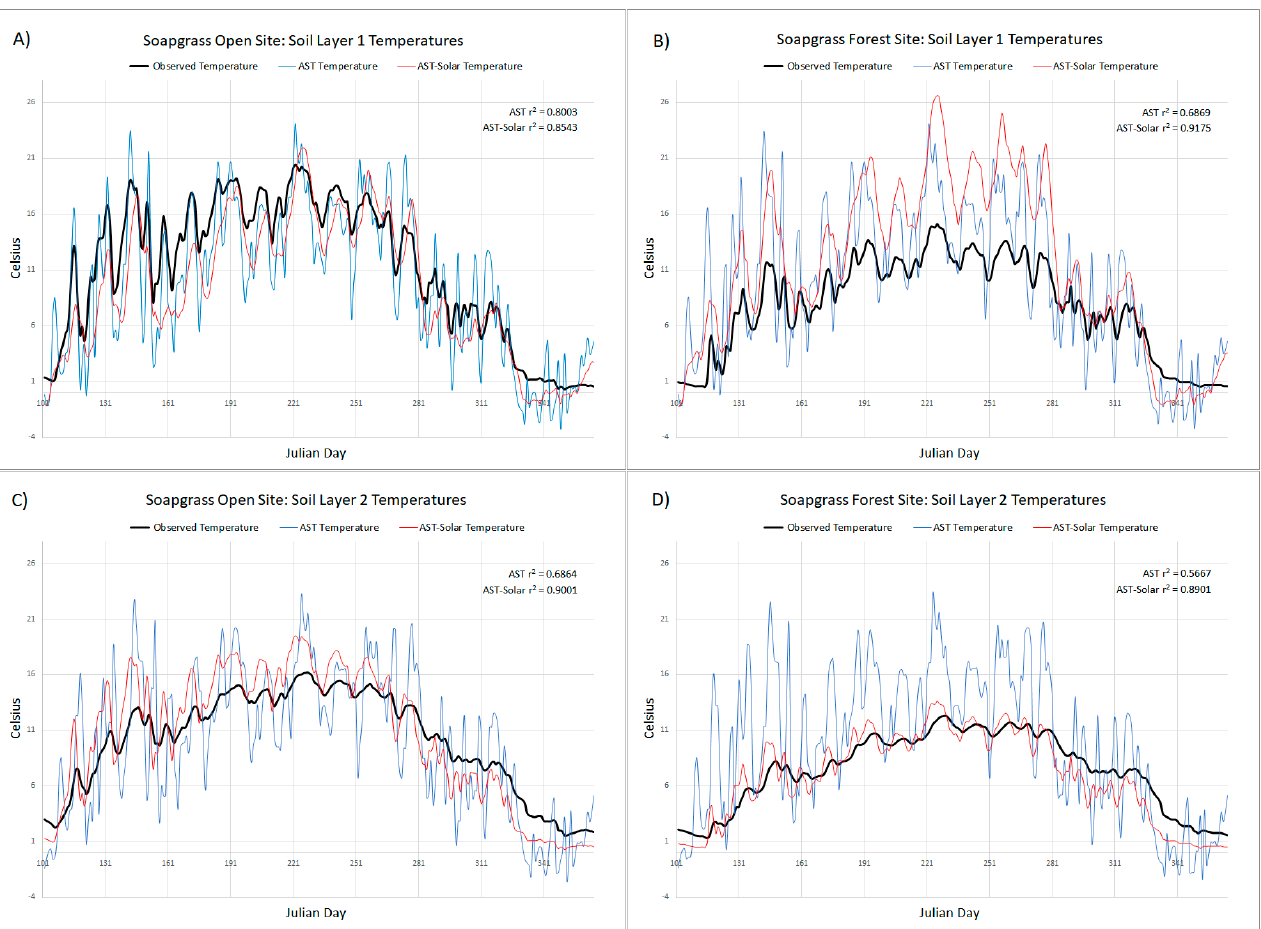
Figure 5. All panels compare observed data for the year 2005, AST model results, and AST-Solar model results. (Panel A ) Soapgrass Open Site Soil Layer 1 temperature results. (Panel B ) Soapgrass Forest Site Soil Layer 1 temperature results. (Panel C ) Soapgrass Open Site Soil Layer 2 temperature results. (Panel D ) Soapgrass Forest Site Soil Layer 2 temperature results. Simulation r 2 values are calculated using Julian days 101–365. Ignoring the first 100 days prevented the AST model from being penalized for its 100-day phase lag, which only occurs during the first year of simulation.